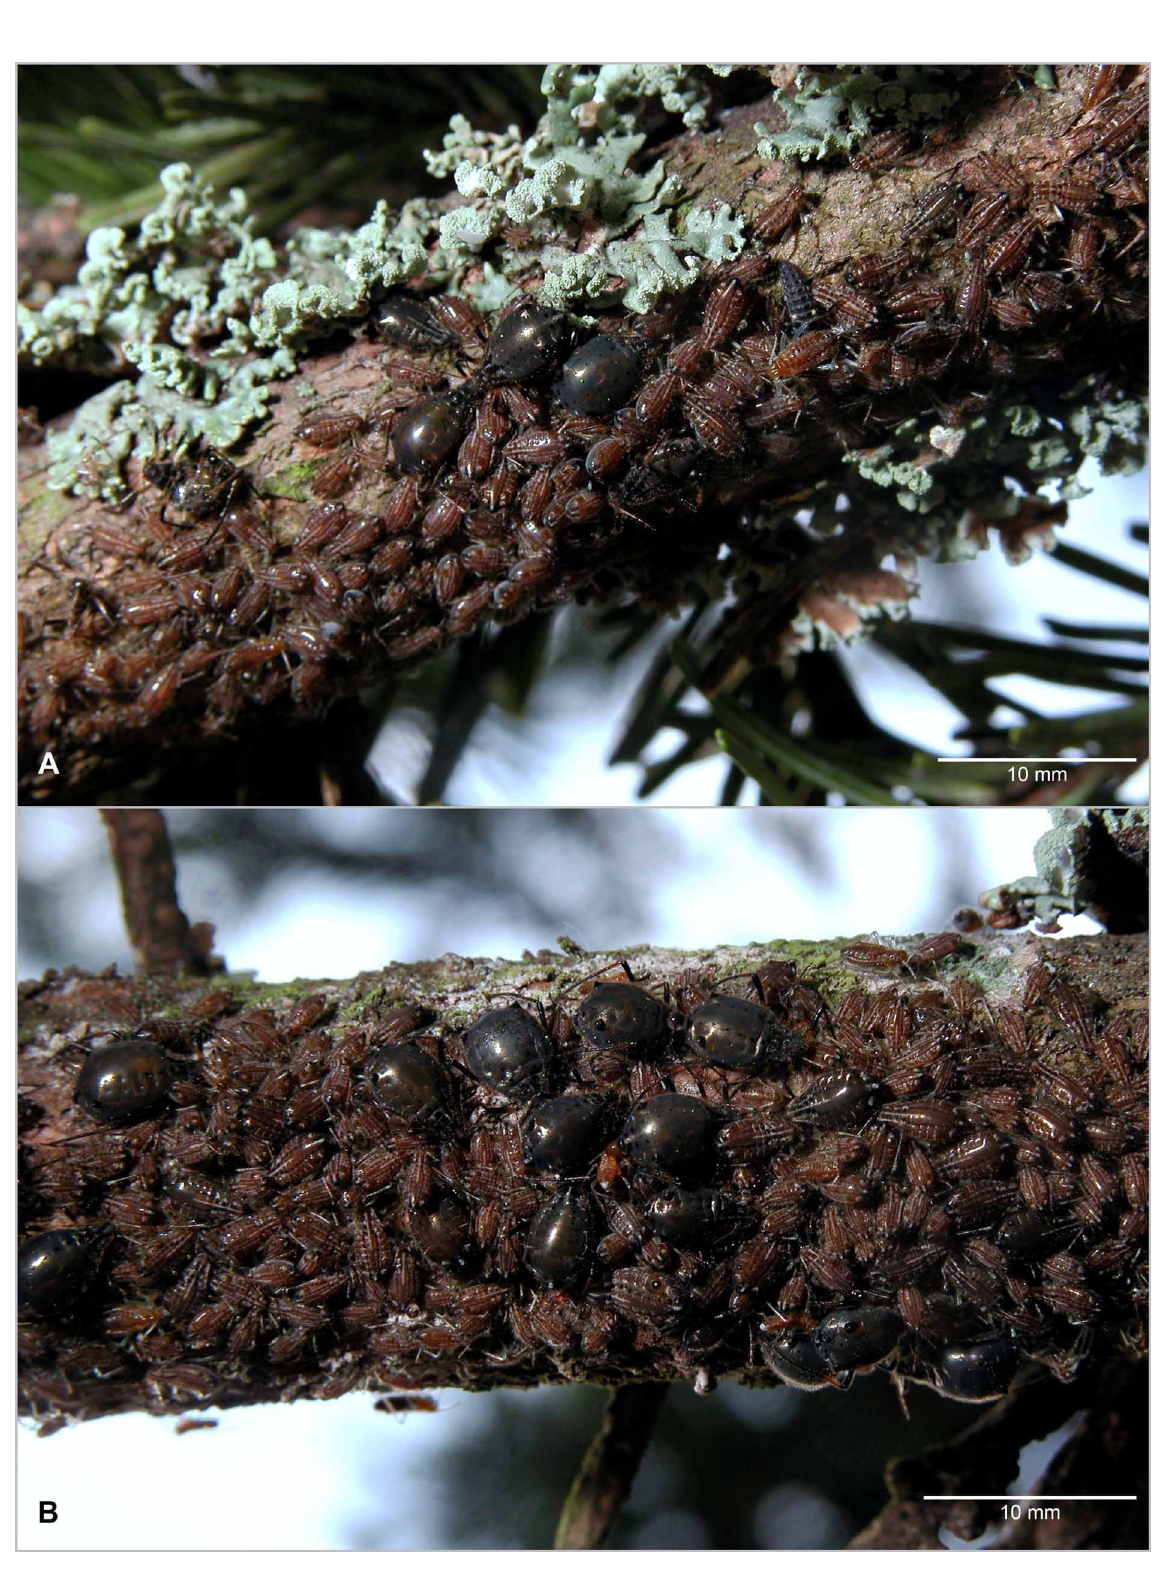
Fig. 50. Cinara (Cinara) confinis Koch, 1856. Colony on underside of branch of Abies sibirica